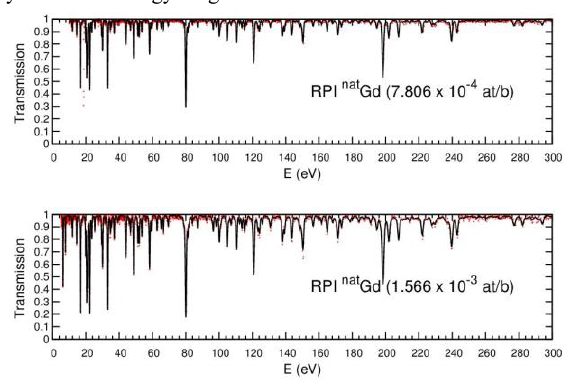
Fig. 5. Comparisons of SAMMY calculations with the resonance parameter (solid line) of the RPI transmission data for natural gadolinium in the energy range 3 eV to 300